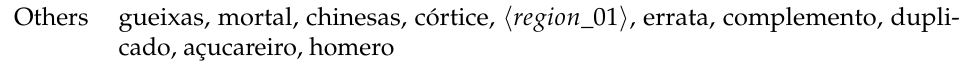
Table 17. Top-10 features for infraction prediction using numerical data removal with SVM.